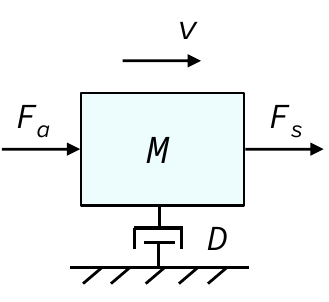
Figure 1. Schematic of one-mass dynamic